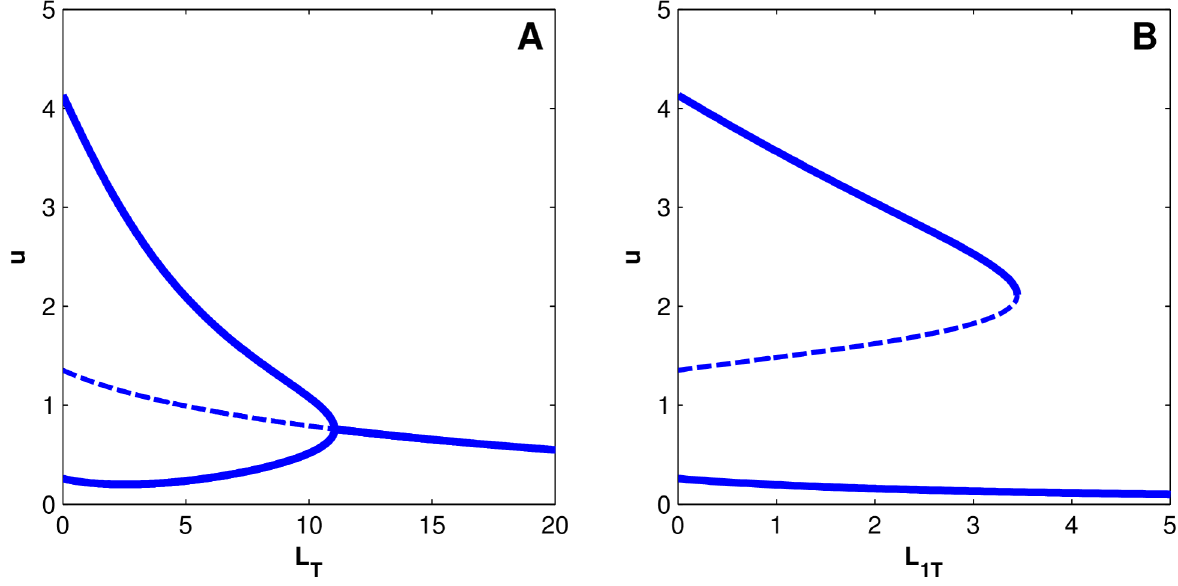
Figure 2. Bifurcation diagram of the genetic toggle switch when the repressor can decay from the load-repressor complex. The thick lines are stable steady states, the dashed lines are unstable steady states. (A). A load is added symmetrically to both sides of the toggle. The stable states of only one Repressor molecule with respect to the load are shown. With zero load the toggle switch is bistable with well separated steady states. As the load increases, the two stable states approach each other and the unstable state, and eventually merge in a bifurcation at a critical value of the load. The system is monostable beyond this critical value. (B) A load is added only to Repressor 1. The high state of Repressor 1 approaches the unstable steady state as the load increases and merges with it at a critical value of the load, leaving only the lower state accessible to the system.